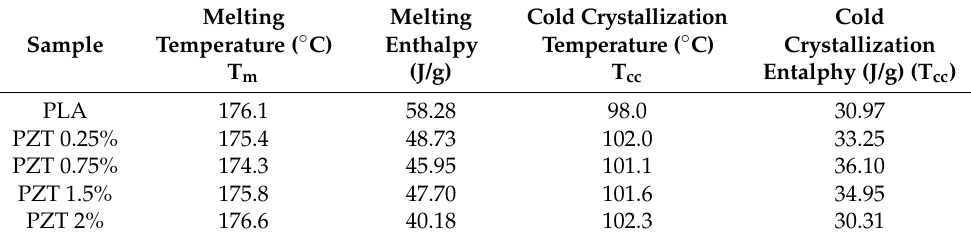
Figure 4. Differential scanning calorimetry of pure PLA and obtained compounds. Table 3. Differential scanning calorimetry (DSC) data for PLA and nanocomposites obtained.